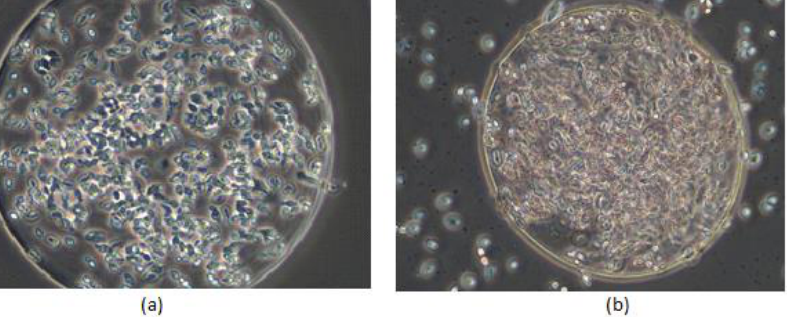
Figure 1. Optical microscopy images at 400 × magnification of ND1 strain after microencapsulation treatment in alginate ( a ) and during the fermentation process ( b ).